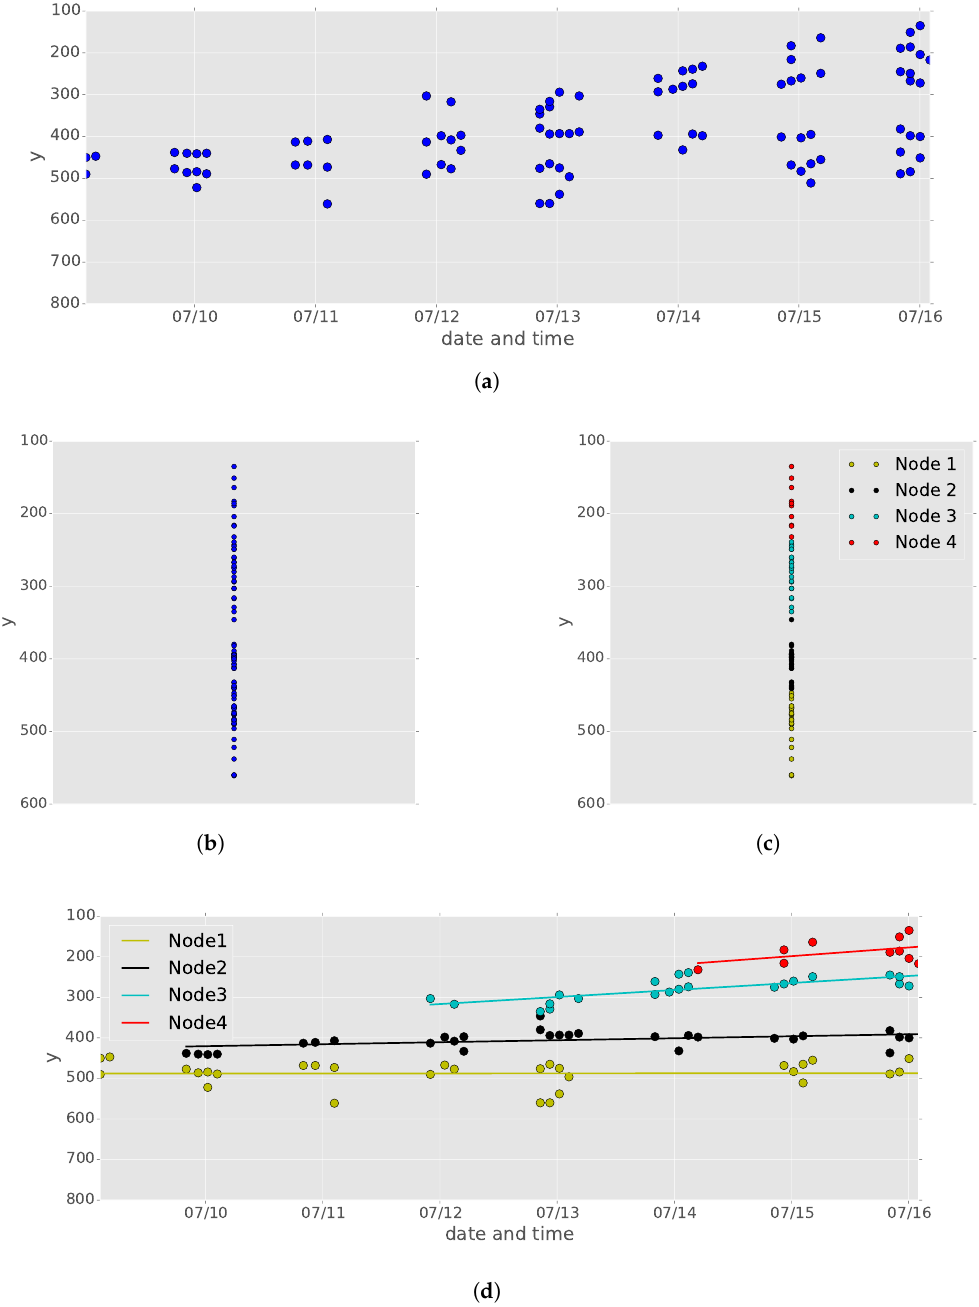
Figure 4. ( a ) typical results of node detection for time-series images of a tomato seedling; ( b ) after removing date and time information; ( c ) after applying affinity propagation, where data points with the same color belong to the same clusters; ( d ) after applying linear regression to each